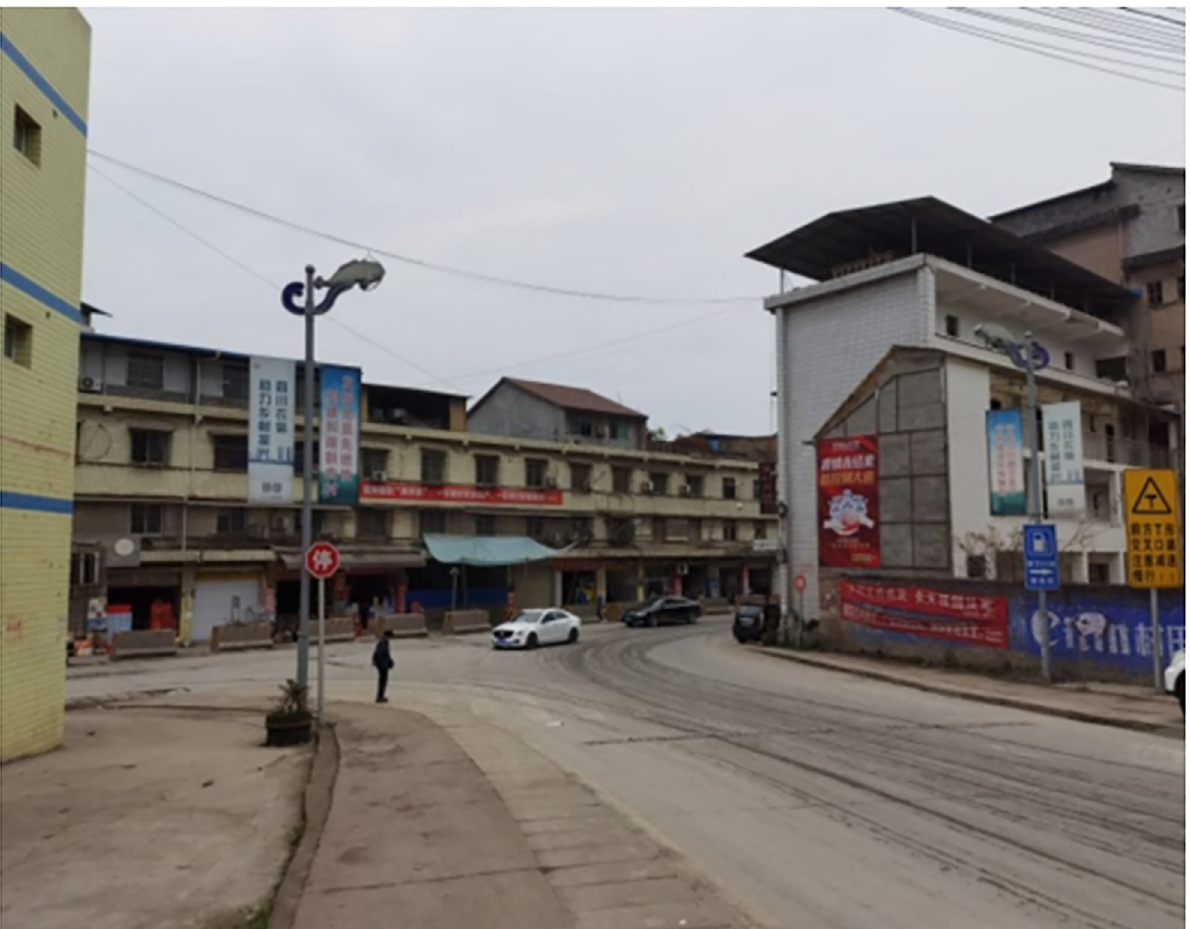
Fig 1. A long downhill T-junction in Zizhong,